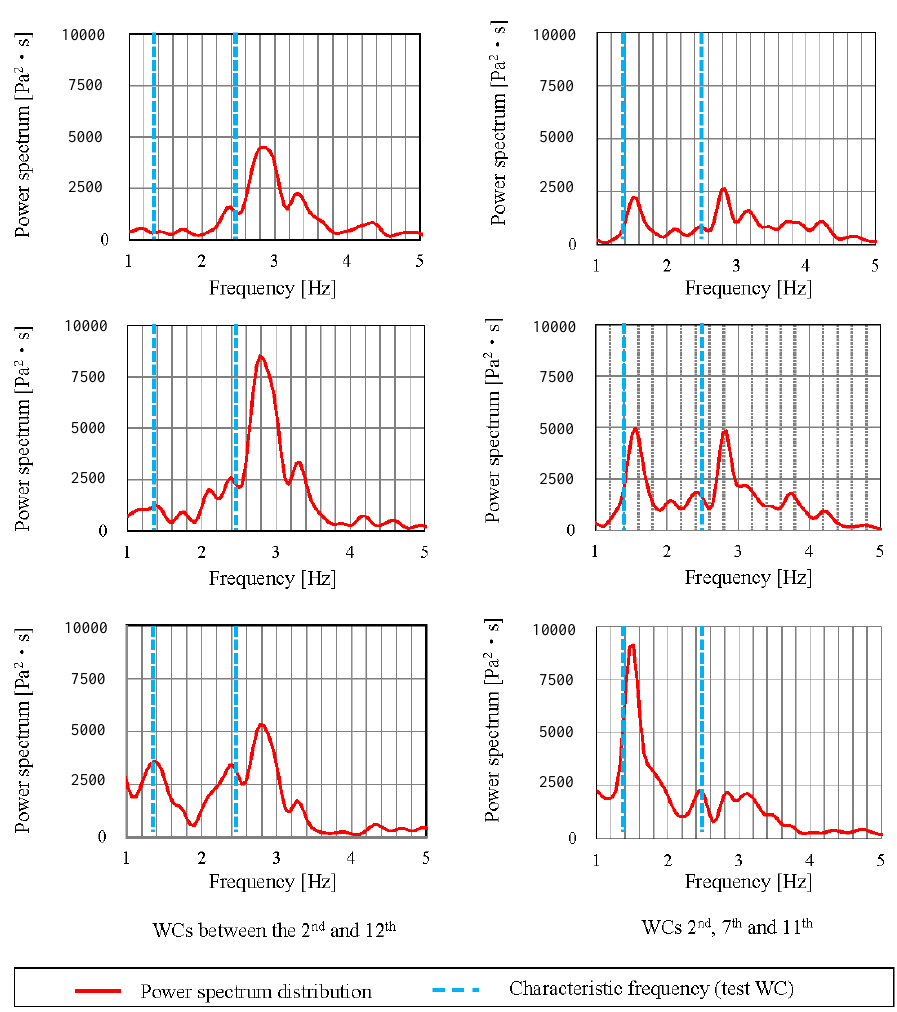
Figure 5 . An example of the power spectrum density distribution. Figure 5. An example of the power spectrum density